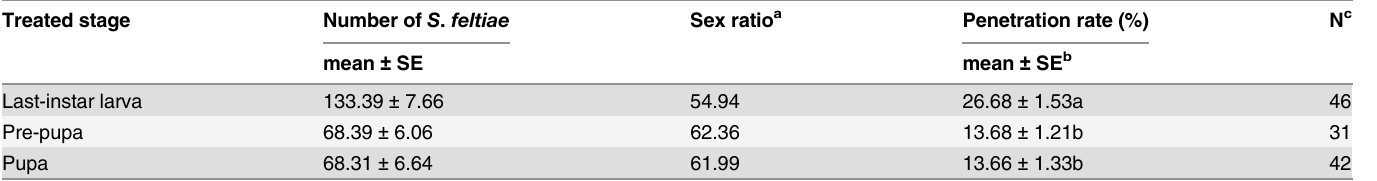
Values followed by identical lowercase letters within a column are not signi fi cantly different at α = 0.05 (Dunn's multiple comparison test). c Number of CPB cadavers dissected.